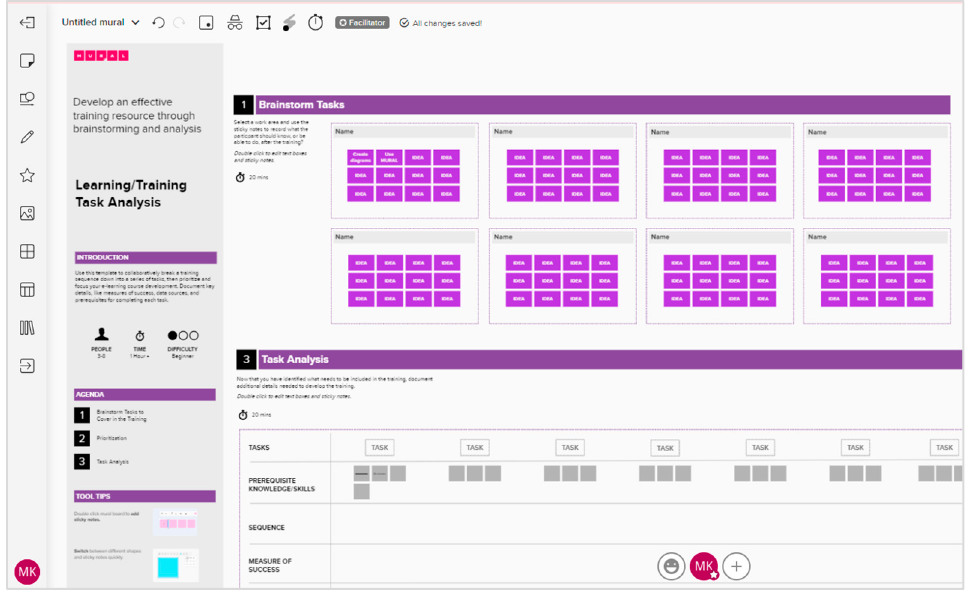
Figure 6. Mural dashboard “Task analysis.”